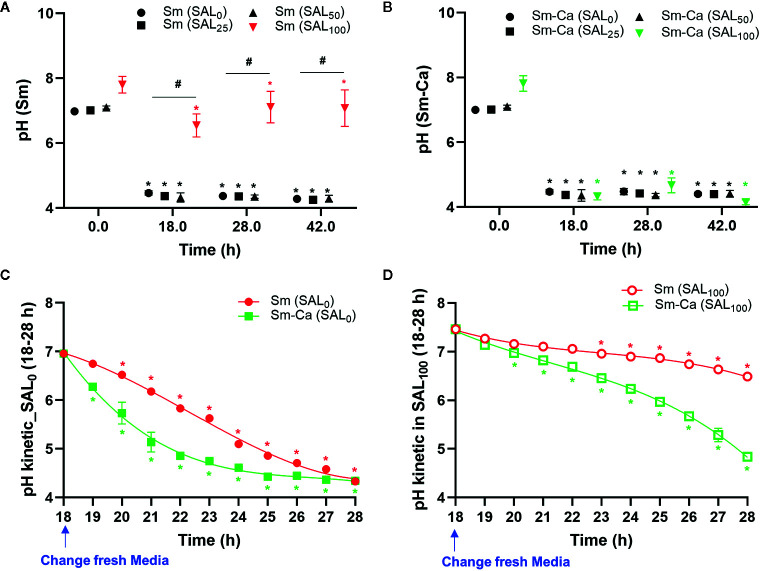
Effect of human saliva on the pH of biofim supernatants in Sm and Sm-Ca biofilms. pH value at early (18 h), middle (28 h), and late (42 h) phases of Sm (A) and Sm-Ca (B) biofilms in different saliva ratios. Sm and Sm-Ca showed similar pH patterns under most culture conditions (SAL0, SAL25, and SAL50), while Sm biofilm showed a completely different pH pattern when cultured under SAL100. Time-lapsed pH measurements of Sm and Sm-Ca biofilms in SAL0
(C) and SAL100
(D) during the middle phase (from 18 h to 28 h). Asterisk indicates that the p-values are significantly different from the pH of the starting point (ANOVA with Dunnett; *P < 0.05). Hash indicates that the p-values are significantly different among groups (Student’s t-test; #P < 0.05).